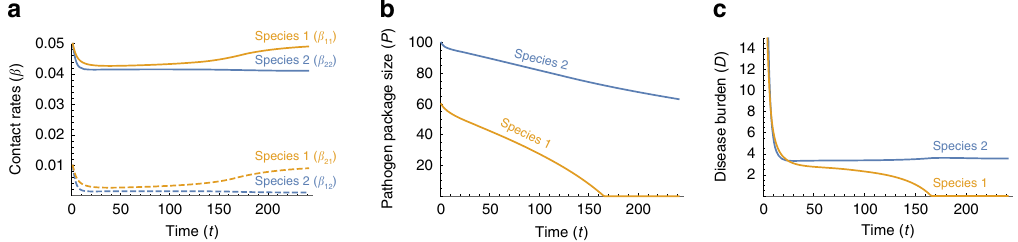
Fig. 3 Disease-introgression dynamics between two species with symmetric initial conditions. The dynamics are described by the two-time-scales model (Fig. 2), following Eqs. (1) – (15). The initial conditions are assumed to be symmetric for the two species ( β ii ¼ β jj and β ij ¼ β ji ), and therefore, the dynamics for the two species are identical, indicated by red curves. a Between-species contact rates ( β ij , i ≠ j ) appear in solid curves, and within-species contact rates ( β ii ) appear in dashed curves (Eqs. (10) – (13)). b Pathogen package size ( P i ), measured as number or diversity of novel pathogens to which the species are vulnerable (Eqs. (14) and (15)). c Disease burden ( D i ), proportional to pathogen package size P i and to the impact of diseases on each of the species, F i (Eqs. (1) and (2)). Three phases are observed in the dynamics: (1) Initial response to heavy disease burden, with decreased contact rates (orange); (2) Long-lasting stable phase with low but steady levels of disease burden (green); (3) Destabilization following the release from disease burden and recovery to initial conditions (blue). The ð 0 Þ ¼ β ð 0 Þ ¼ 0 : 05; β ð 0 Þ ¼ β ð 0 Þ ¼ 0 : 01; γ ¼ 0 : 045; P ð 0 Þ ¼ P ð 0 Þ ¼ 100, with scaling parameters parameters for the scenario modeled are β 1 2 11 22 12 21 a ¼ 5 ´ 10 (cid:2) 5 , b ¼ 0 : 02, and c ¼ 100